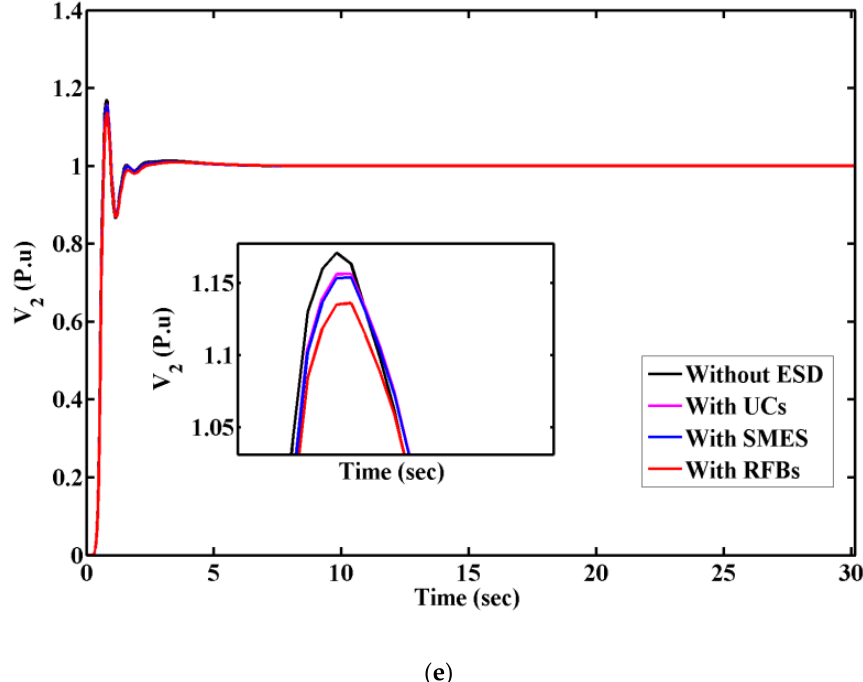
Figure 10. Responses for case-3: ( a ). ∆ f 1 , ( b ). ∆ Ptie 12 , ( c ). ∆ f 2 , ( d ). V 1 and ( e ). V 2. Table 5. Settling time of responses for case-3.